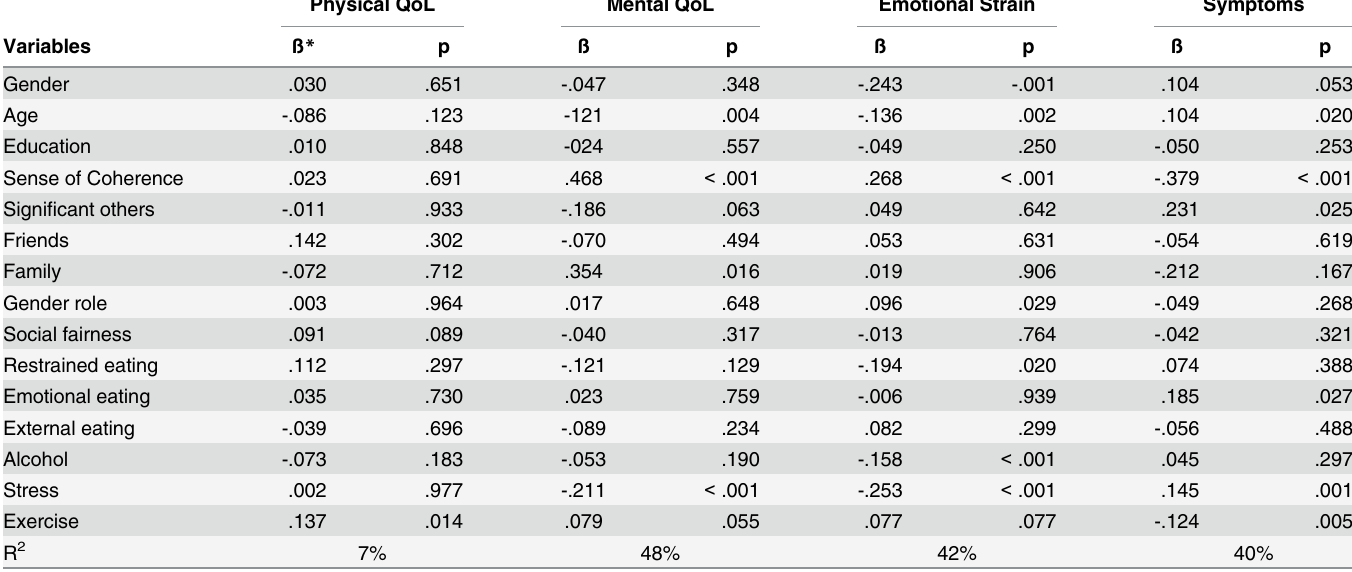
Table 2. Associations between perceived health, quality of life and predictor Variables — Austrian